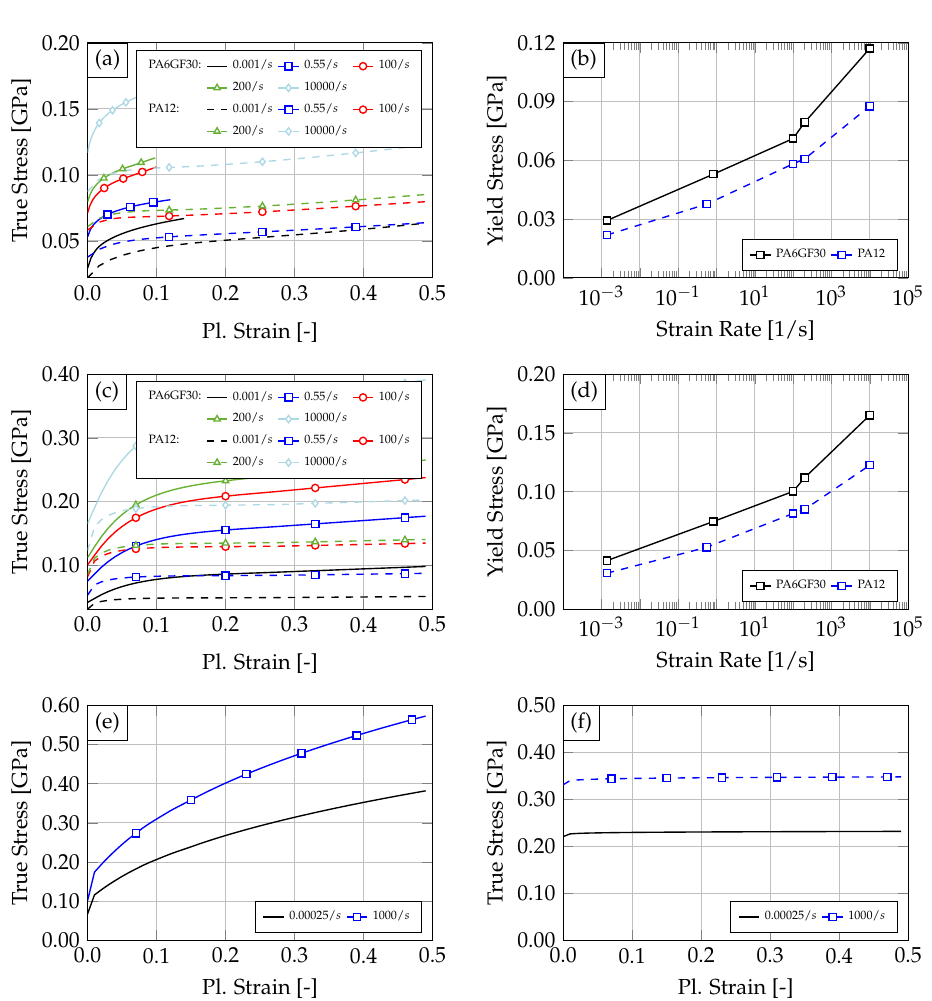
Figure A1. Input parameters of the material models for the HVB insulation and copper-based on [15]: ( a ) Implemented stress–strain curves in tensile direction for PA12 and PA6GF30. ( b ) Strain rate dependent yield stress in tensile direction for PA12 and PA6GF30. ( c ) Implemented stress–strain curves in compressive direction for PA12 and PA6GF30. ( d ) Strain rate dependent yield stress in compressive direction for PA12 and PA6GF30. ( e ) Implemented stress–strain curves in tensile direction for Cu-OFE R200. ( f ) Implemented stress–strain curves in tensile direction for Cu-OFE R240.